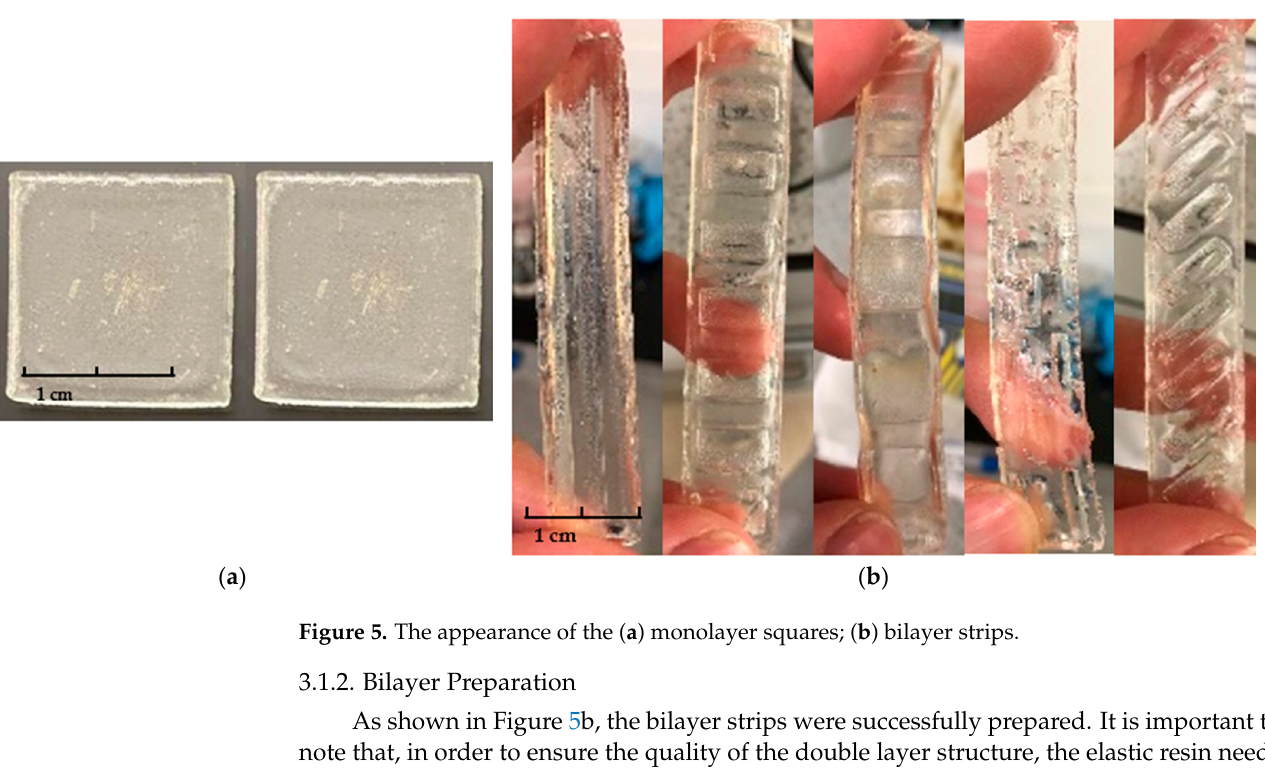
Figure 6. The appearances of bilayer fl ower samples.